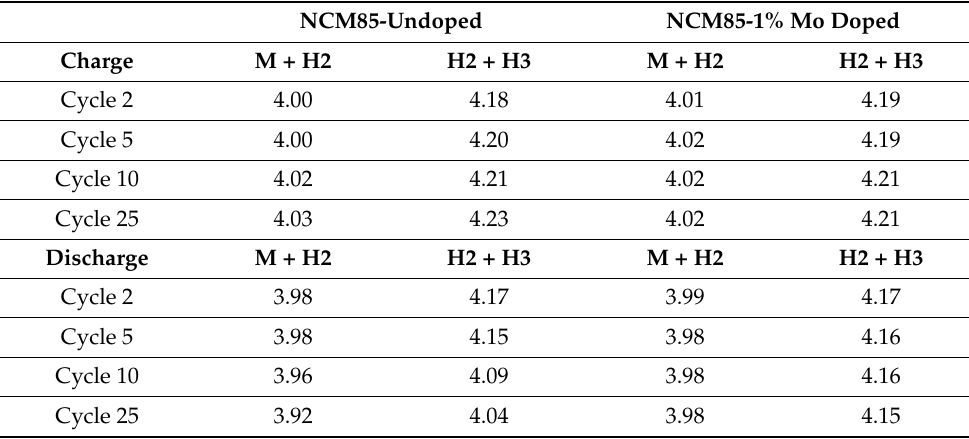
Table 3. Anodic and cathodic peaks potentials (V vs. Li/Li + ) related to the Ni 2+ /Ni 4+ redox and M+H2 and H2+H3 phase transitions measured for undoped and 1 at. % Mo-doped electrodes upon cycling at C/10 (cycle 2) and C/3 rates (cycles 5, 10, and 25).